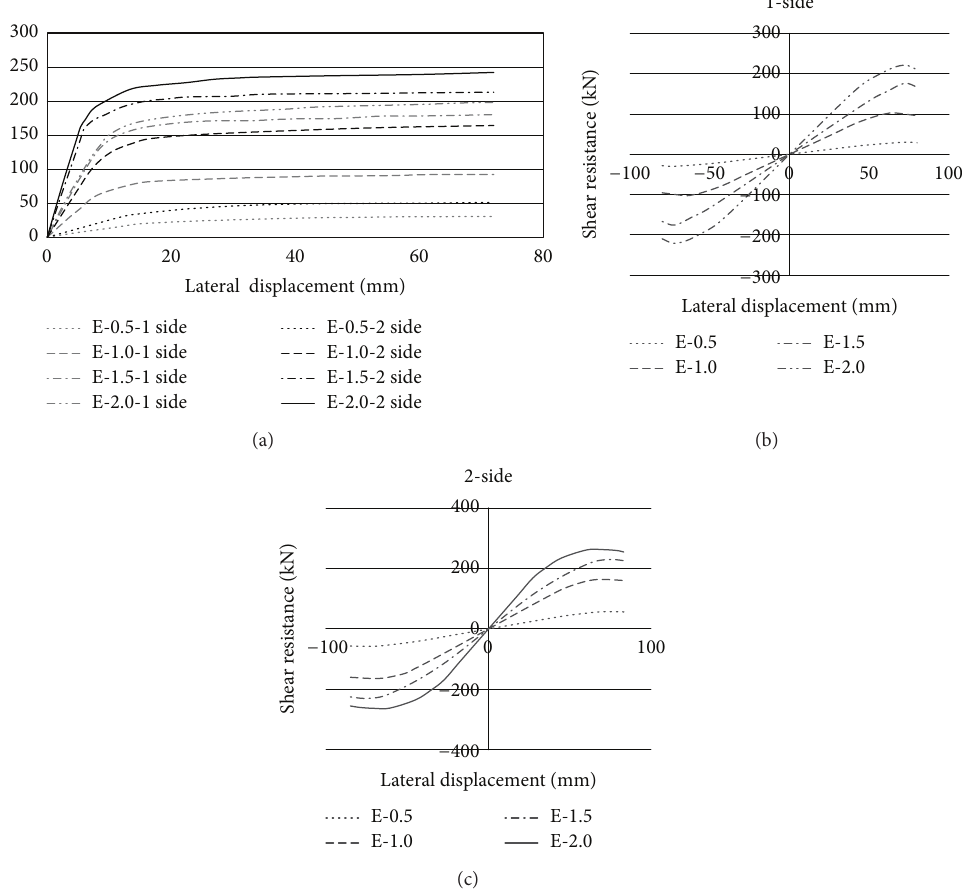
Figure 7: Curves of specimens E. (a) Monotonic curves. (b) Hysteretic envelope curves 1-side. (c) Hysteretic envelope curves